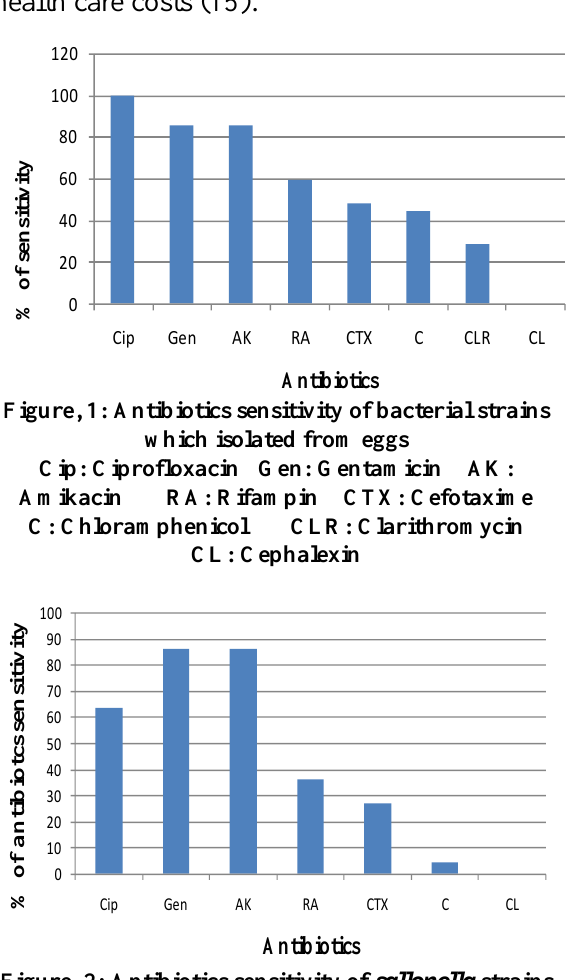
Figure, 2: Antibiotics sensitivity of sallonella strains which isolated from stool samples Cip: Ciprofloxacin Gen: Gentamicin AK: Amikacin RA: Rifampin CTX: Cefotaxime C: Chloramphenicol CLR: Clarithromycin CL: